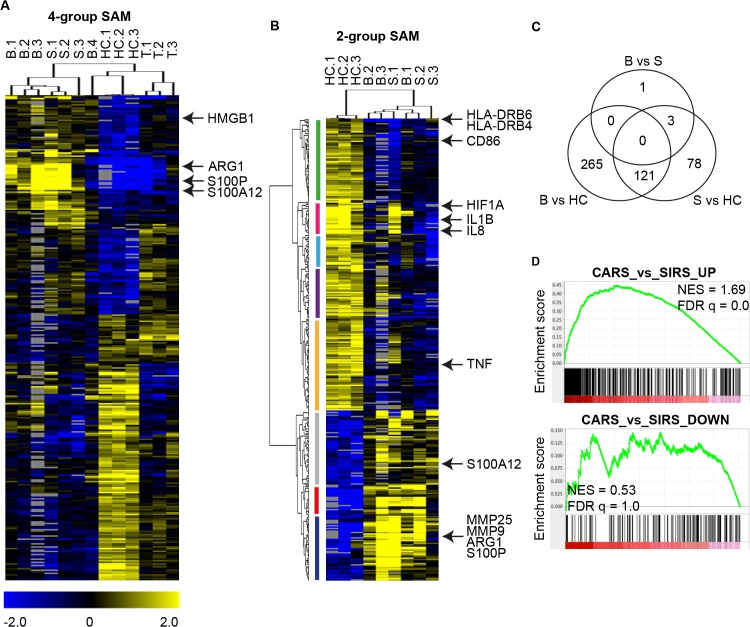
Gene expression profile analyzes show that monocytes from patients with metastatic breast cancer are similar to reprogrammed monocytes from sepsis patients.(A) Four-group significance analysis for microarray (SAM) between healthy controls (H.1-3), patients with metastatic breast cancer (MBC; B.1-4), sepsis (S.1-3) or tuberculosis (T.1-3) (312 genes, FDR<0.05), reveal that monocytes from MBC patients cluster with monocytes from sepsis patients. (B) Two-group SAM between monocytes from [MBC and sepsis patients] compared with monocytes from healthy controls (343 genes, FDR<0.05). Genes relevant in MDSCs or monocyte reprogramming are highlighted. See S3 and S4 Tables, and S1 File for detailed gene list. (C) Venn diagram of overlapping significant differentially expressed genes between monocytes from [patients with MBC (B) and HC (FDR <0.05)], [patients with sepsis (S) and HC (FDR < 0.05)] and [patients with MBC (B) and patients with sepsis (S; FDR < 0.25)]. Gene symbols are provided in S4 File. (D) Gene set enrichment analysis (GSEA) of CARS monocyte-associated (top panel) and SIRS monocyte-associated (bottom panel) gene sets [38] carried out on a gene list of all genes ranked according to their significance of differential expression between monocytes from MBCs (n = 3) versus HCs (n = 3). Normalized enrichment score (NES) and false discovery rate q-values are provided.